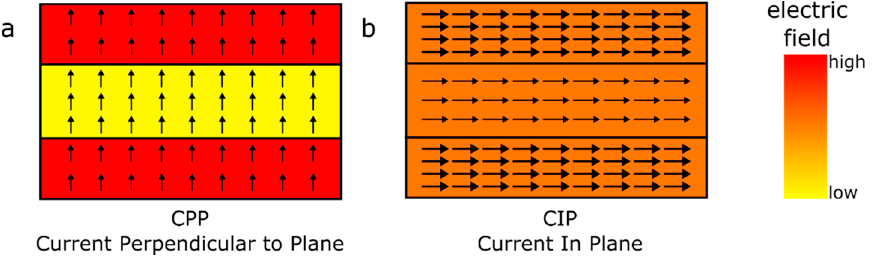
Figure 2. Simple double layer stacks in CPP ( a ) and CIP ( b ) configuration. CPP leads to a homogeneous current density (arrows) while the electric field is inhomogeneous, where CIP exhibits a homogenous electric field and an inhomogeneous current density.